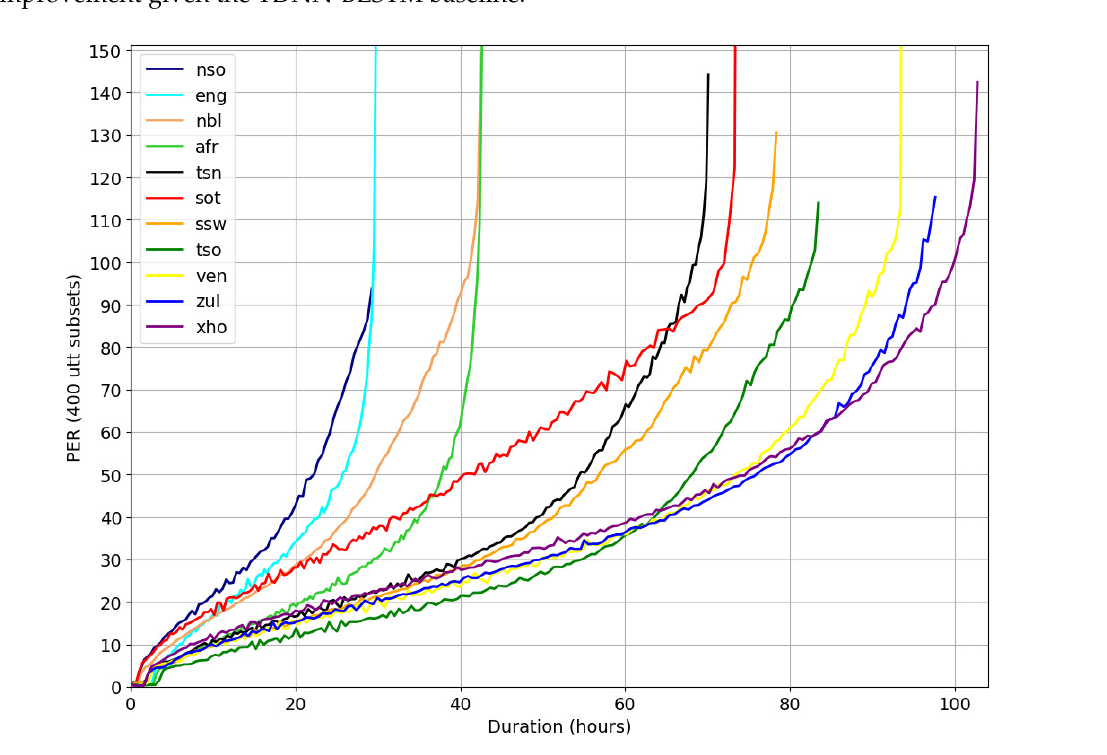
Figure 1. Local phone error rates (PERs) for 400 utterance subsets of the Aux1